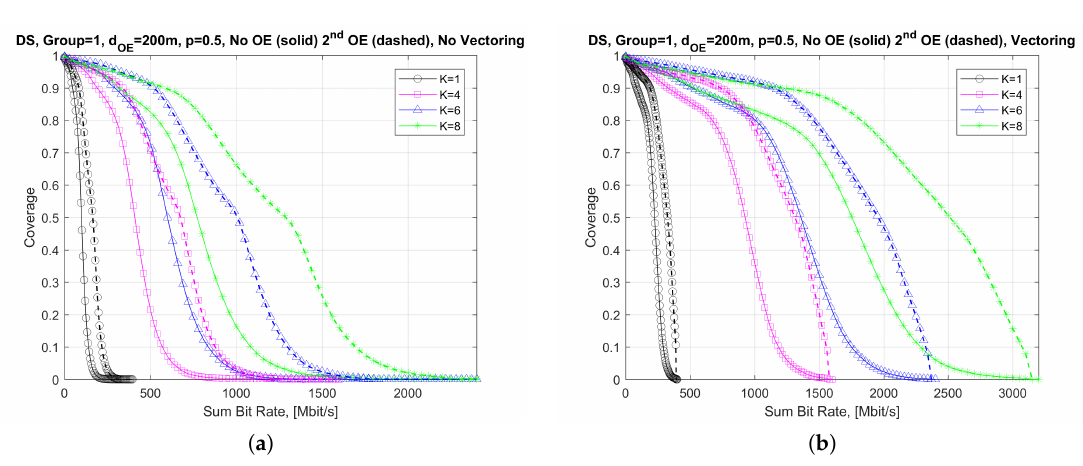
Figure 7. Sum bit rate coverage for group 1, d OE = 200 m—variable of number of pairs per radio node, user activity factor, p = 0.5, DS with non-vectoring ( a ) and DS with vectoring ( b